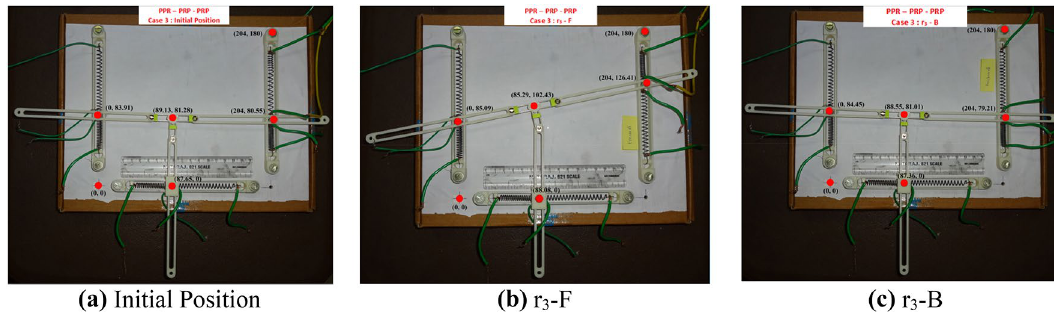
Fig. 12 Actuation of SMA springs of C5 manipulator (Condition 3)